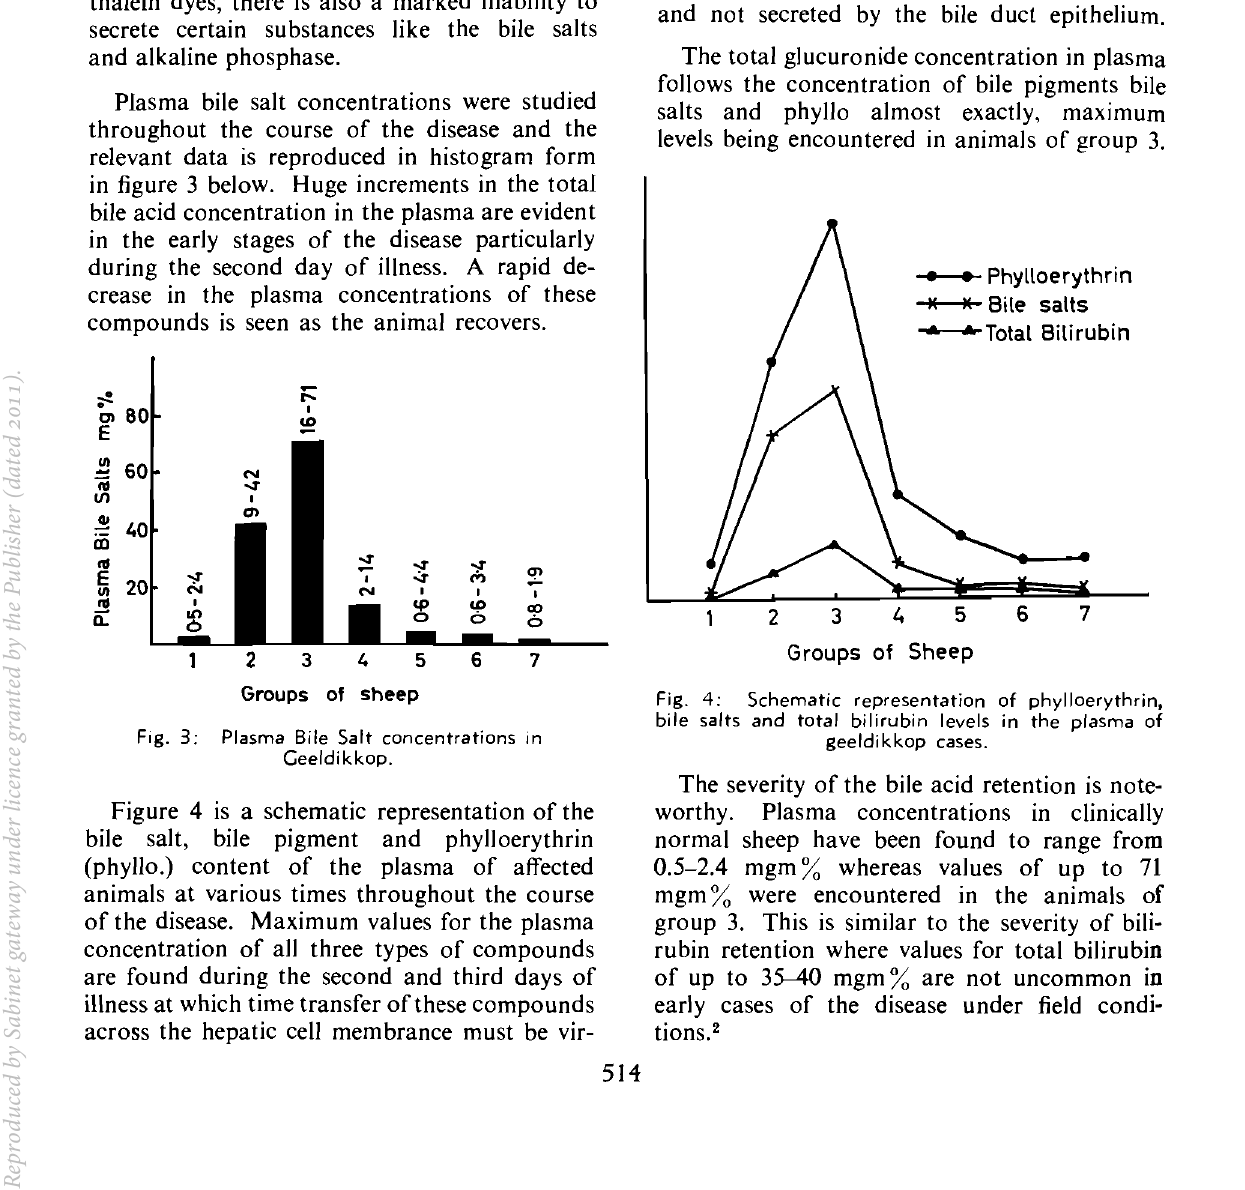
Schematic representation of phylloerythrin. bile salts and total bilirubin levels in the plasma of geeldikkop